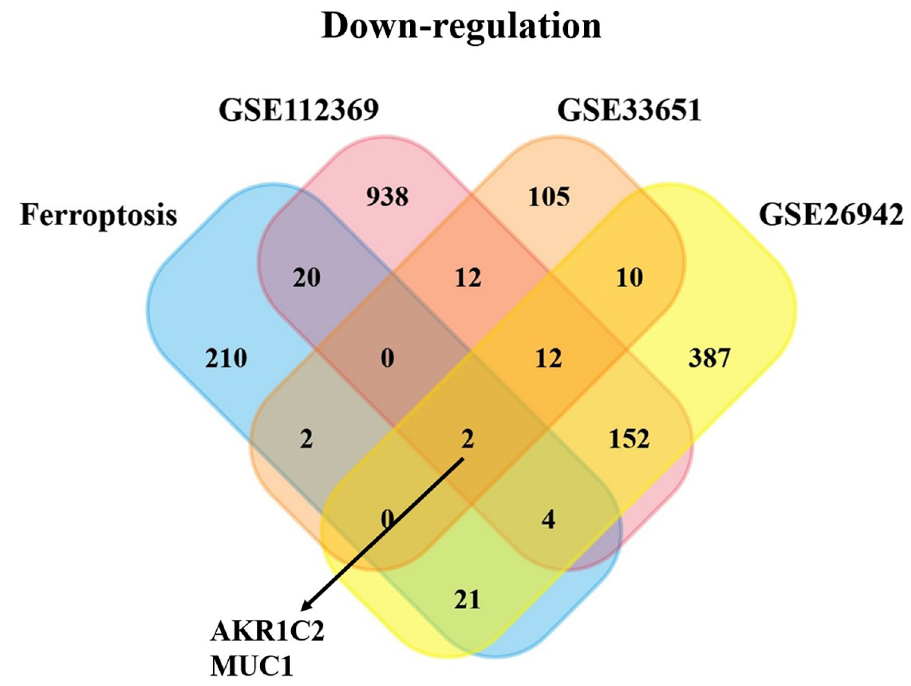
Fig 1. Venn analysis depicted the downregulated co-DEGs between the ferroptosis related gene dataset and the three GEO datasets. There are two downregulated genes in the four datasets, named as AKR1C2 and MUC1.